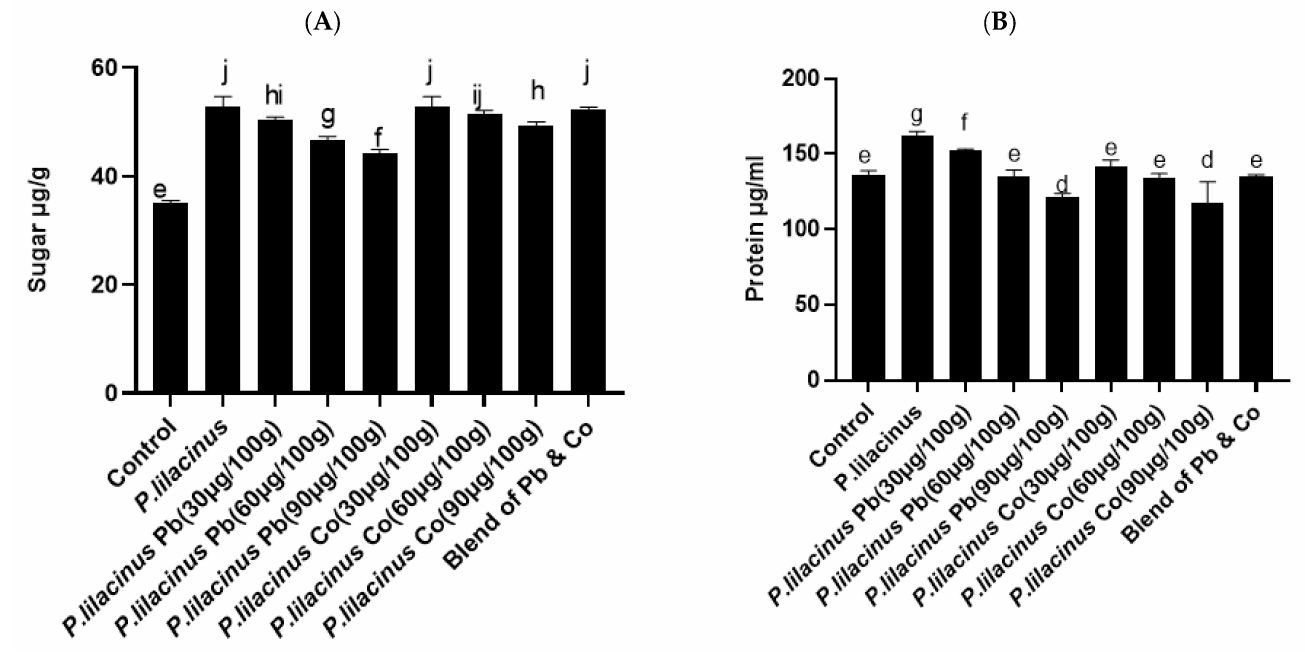
Figure 6. ( A ) Effect of lead and cobalt stresses on sugar of S. lycopersicum inoculated with P. lilacinus and without P. lilacinus . Bars represents mean of triplicates with ± SE. Alphabets above the bars are different significantly from one another at p ≤ 0.05. ( B ) Effect of lead and cobalt stresses on protein of S. lycopersicum inoculated with P. lilacinus and without P. lilacinus . Bars represents mean of triplicates with ± SE. Alphabets above the bars are different significantly from one another at p ≤